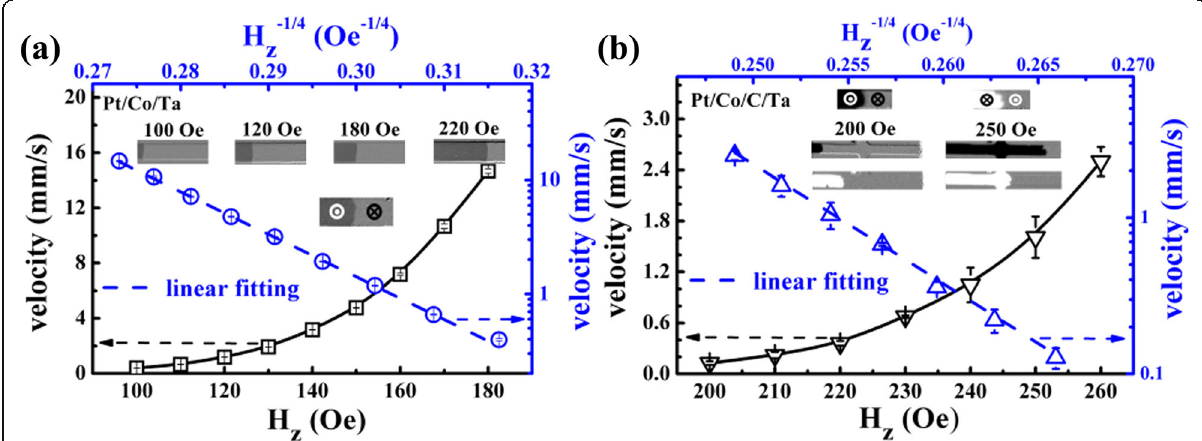
Fig. 1 DW velocity as a function of out-of-plane field H z for Pt/Co/Ta ( a ) and Pt/Co/C/Ta ( b ). The insets in a and b represent the snapshots of domains at different fields to show the DW